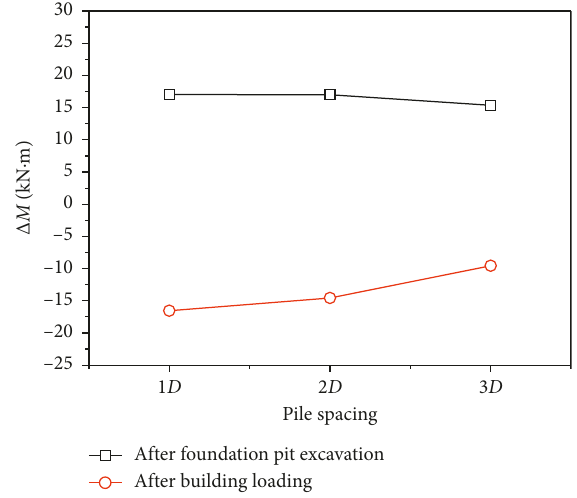
Figure 36: Difference between the additional bending moments.